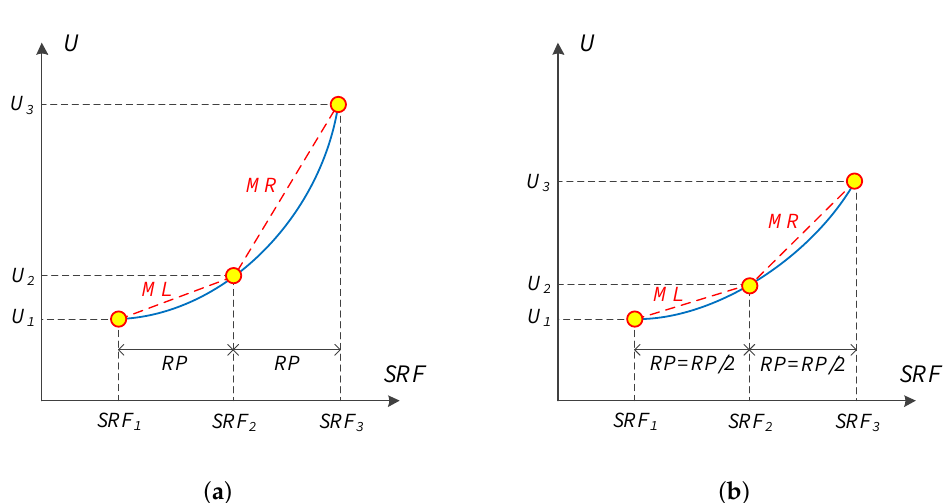
Figure 5. Schematic convergence to the design trigger (DT) within two iterations; for State 2 in Figure 4. ( a ) Initial (old) analysis and ( b ) updated (new) analysis.